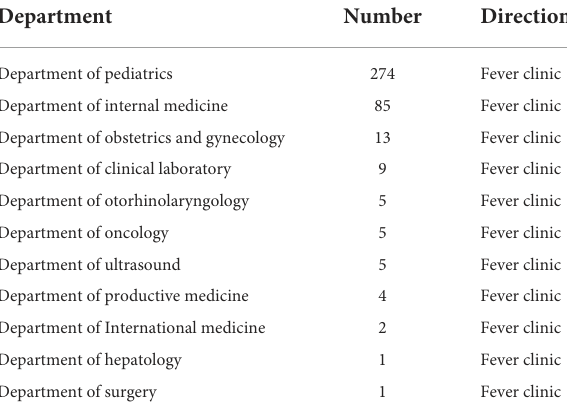
TABLE 1 Fevered patients without history of coming from the epidemic area of